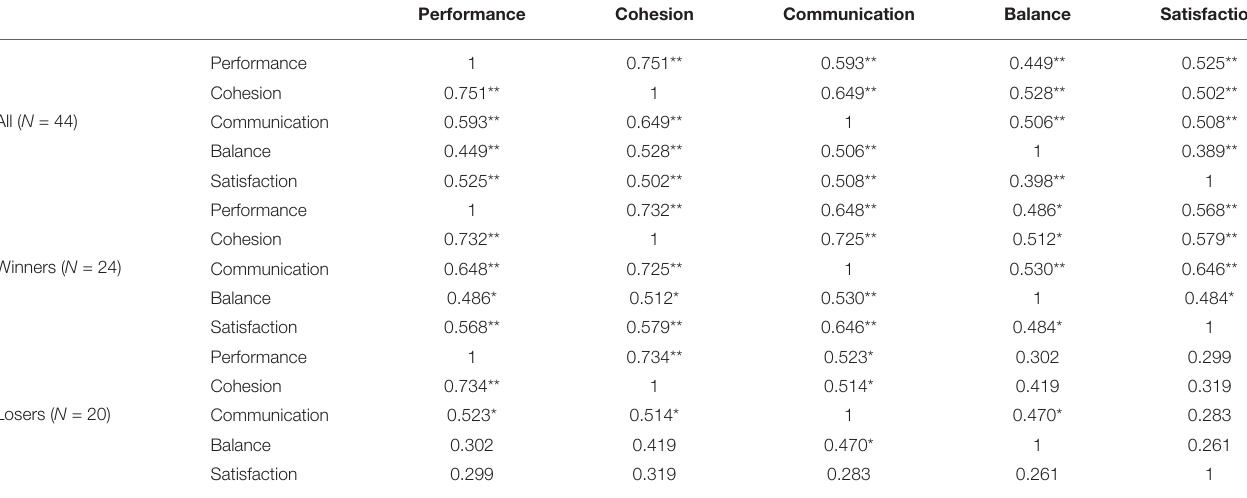
TABLE 8 | Spearman correlations between perceived collaboration quality metrics, ** p < 0.01, * p <